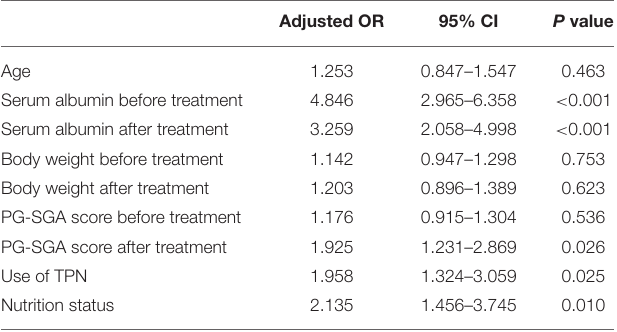
TABLE 5 | Multivariable logistic regression model analysis of factors predicting the hospital stay duration of the malnourished patients with endometrial, cervical or ovarian cancer.